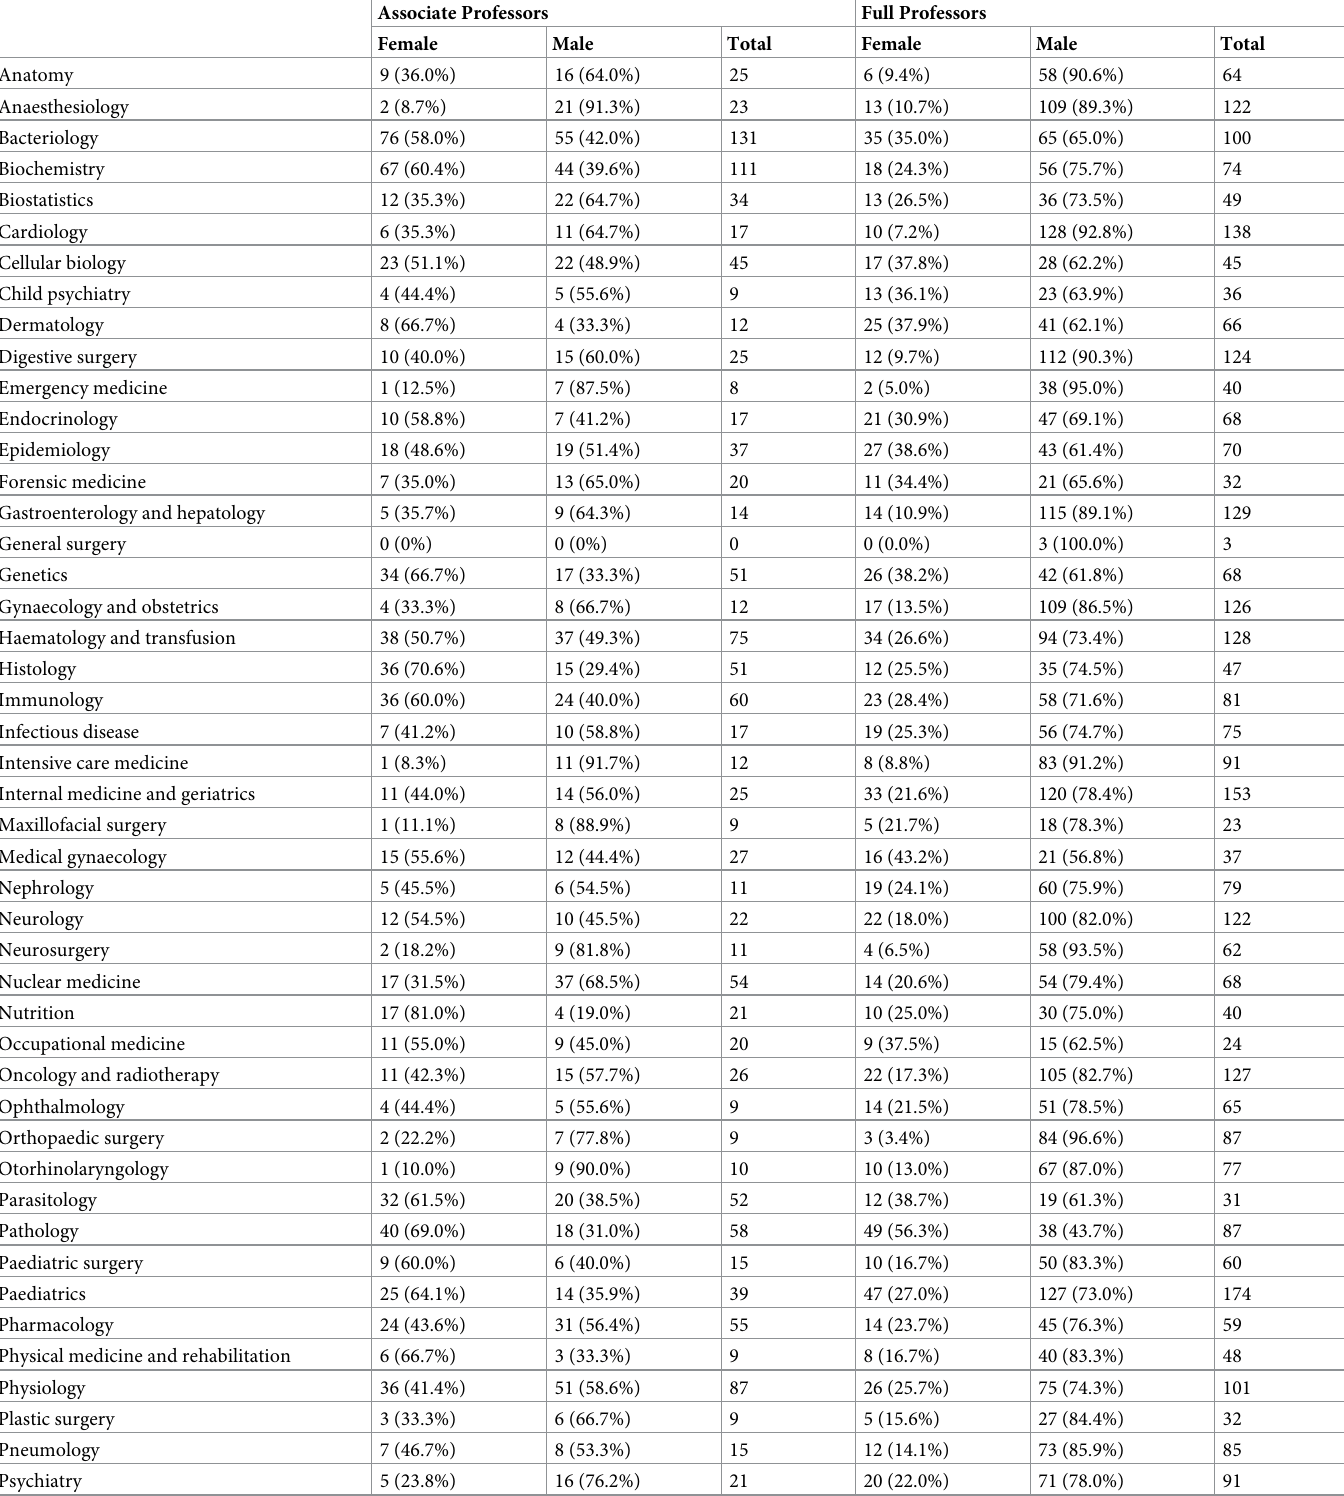
Table 3. Distribution of French Associate and Full Professors according to discipline, CNU-section, and gender in